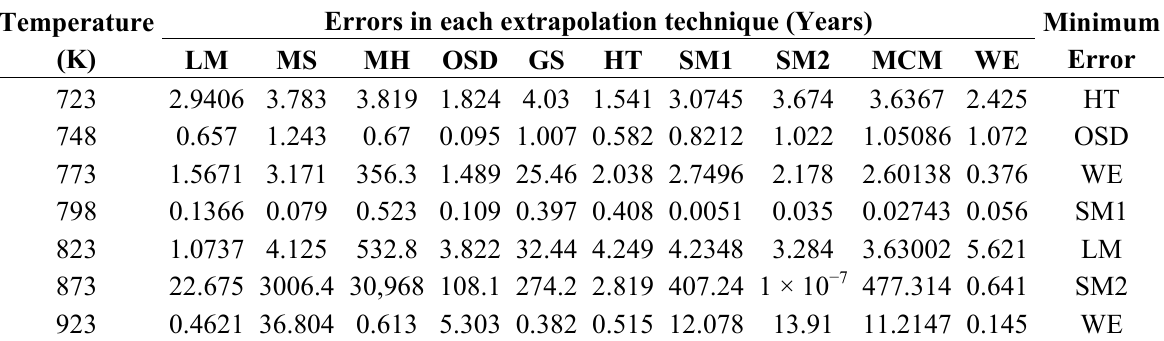
Table 1. Error values for the conventional and modern predictive